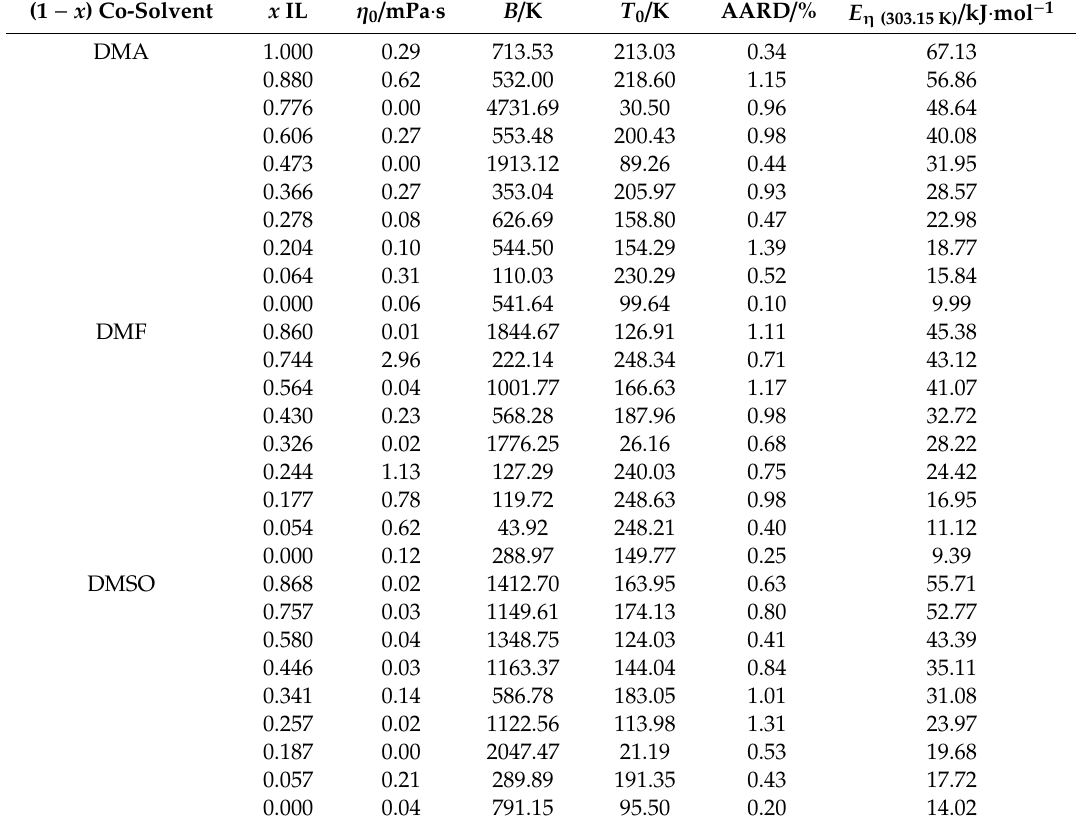
Table 13. The parameters for Equation (7), the average absolute relative deviations, and the energy barriers at 303.15